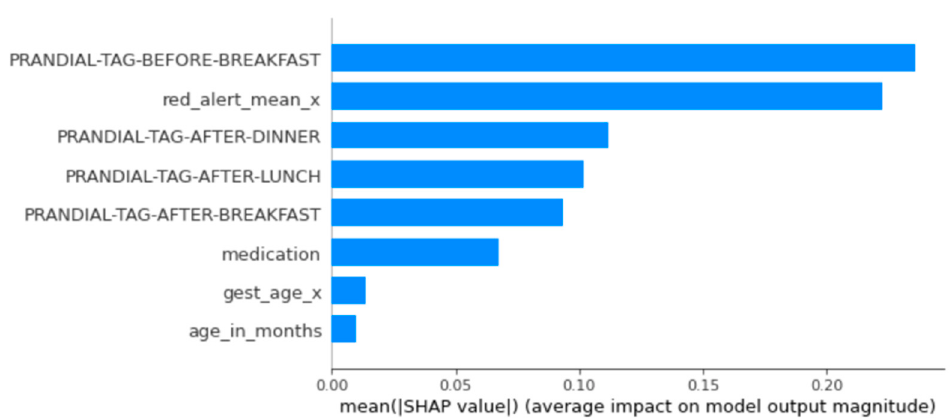
Figure A6. SHAP feature importance ranking for model trained on Tags, Gradients, and EHR features.